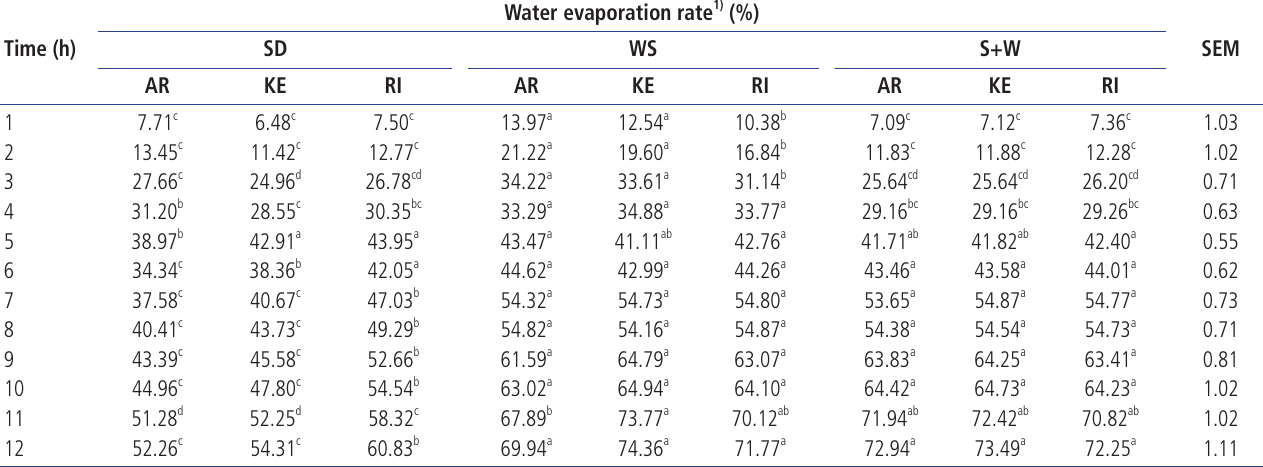
Water evaporation rate 1) (%)